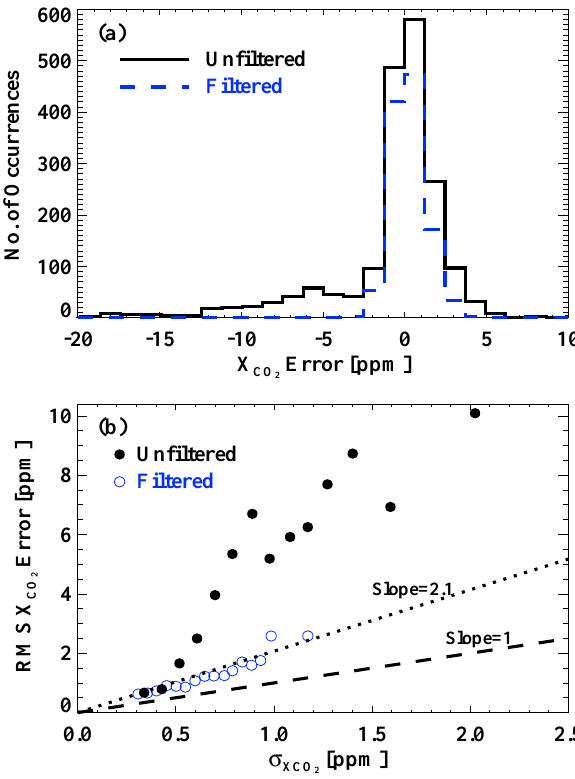
Fig. 12. (a) Histogram of test 6 X CO errors, for both unfiltered 2 retrievals (black, solid) and those passing the post-processing filters (blue, dashed). (b) Plot of test 6 actual RMS errors in X CO vs. a 2 posteriori error σ X , calculated by binning X CO error in bins of CO2 2 σ X . The one-to-one line (dashed) would be expected if the a CO2 posteriori error fully explained the true errors; the best-fit line for the filtered retrievals (dotted) has a slope of